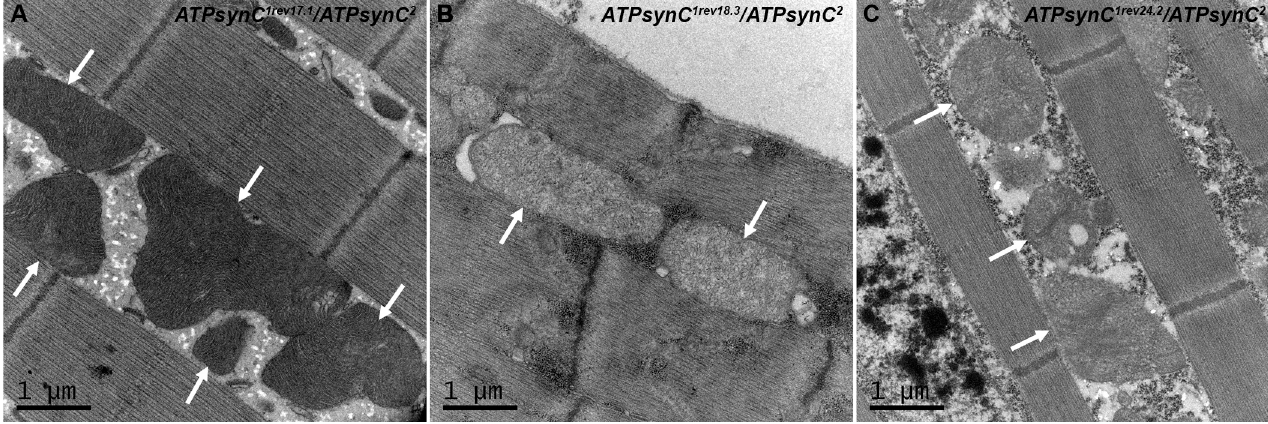
Fig 7. Mitochondria morphology analysis in trans-heterozygotes for representative ATPsynC 1 revertant alleles. Mitochondria in thoracic flight muscles were examined in adult trans-heterozygotes for representative alleles ATPsynC 1rev17 . 1 (A), ATPsynC 1rev18 . 3 (B) and ATPsynC 1rev24 . 2 (C) by using TEM. Arrows point to